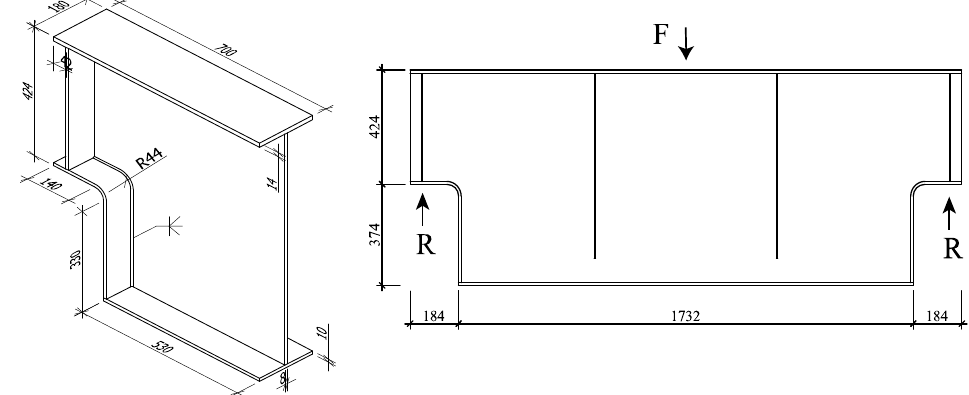
Figure 9. Dimensions of the variable-section support specimens with R-plates.